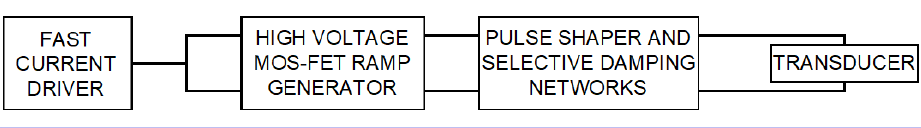
Figure 3. Block diagram of our HV pulsed driver for efficient excitation of broadband